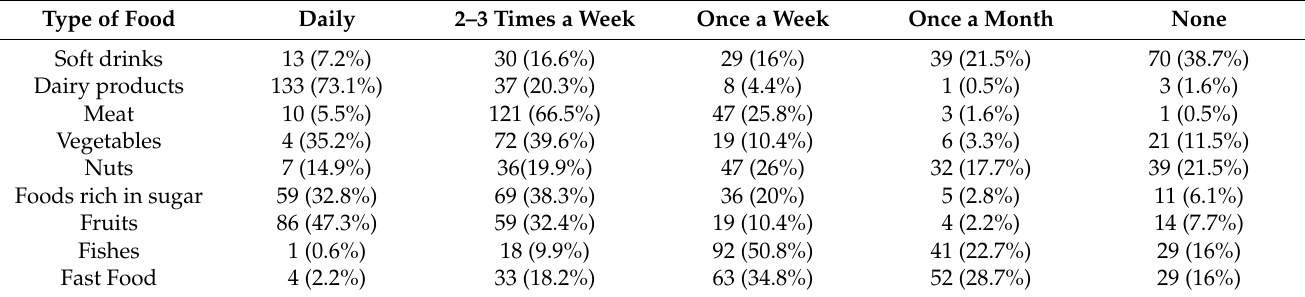
Table 3. Frequency and type of foods and drinks consumed by